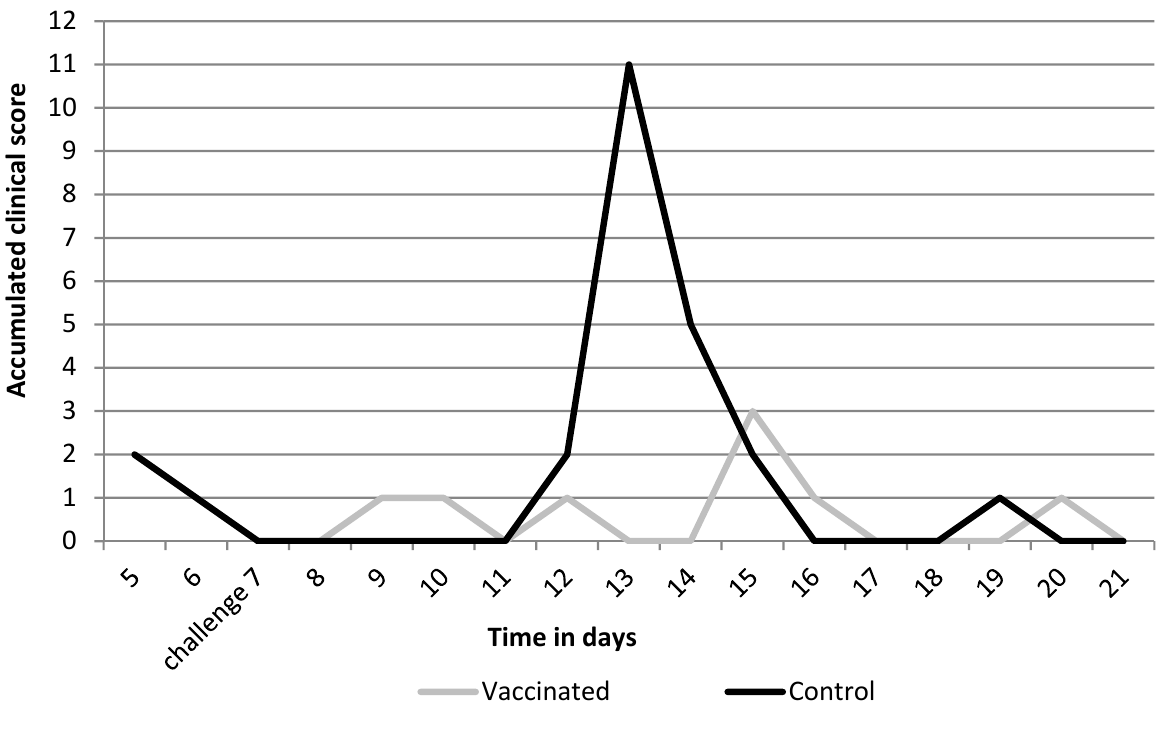
Figure 2. Sum of clinical scores per group after challenge. 3.2. Changes in Ct Values of Genes after Vaccination, or Challenge, or Vaccination and